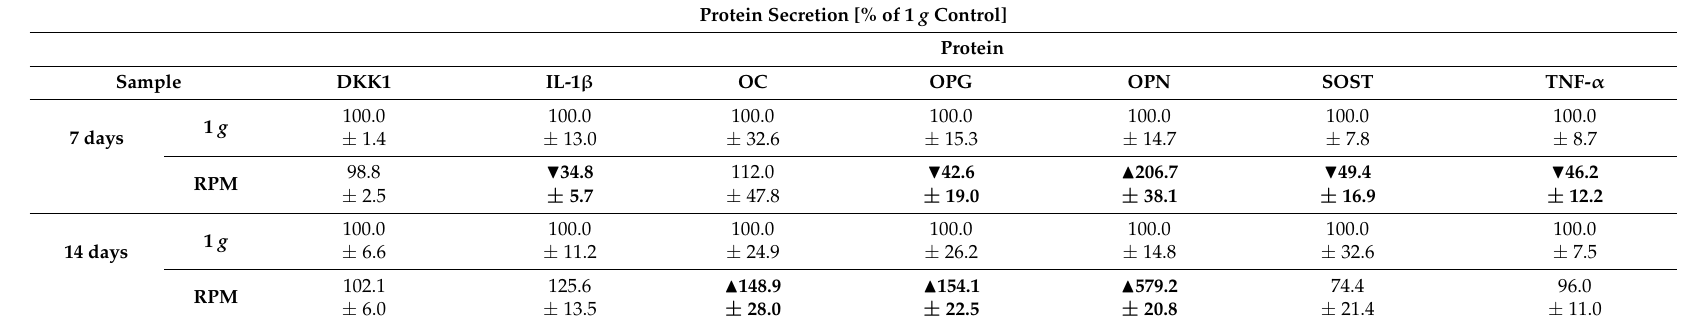
Protein Secretion [% of 1 g